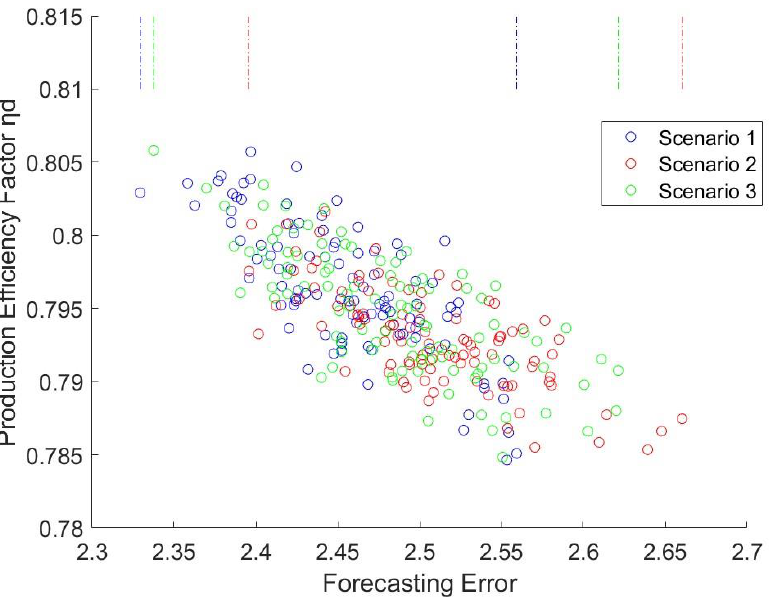
Figure 5. Scenarios 1, 2, and 3 and their forecasting error boundaries (dashed lines).